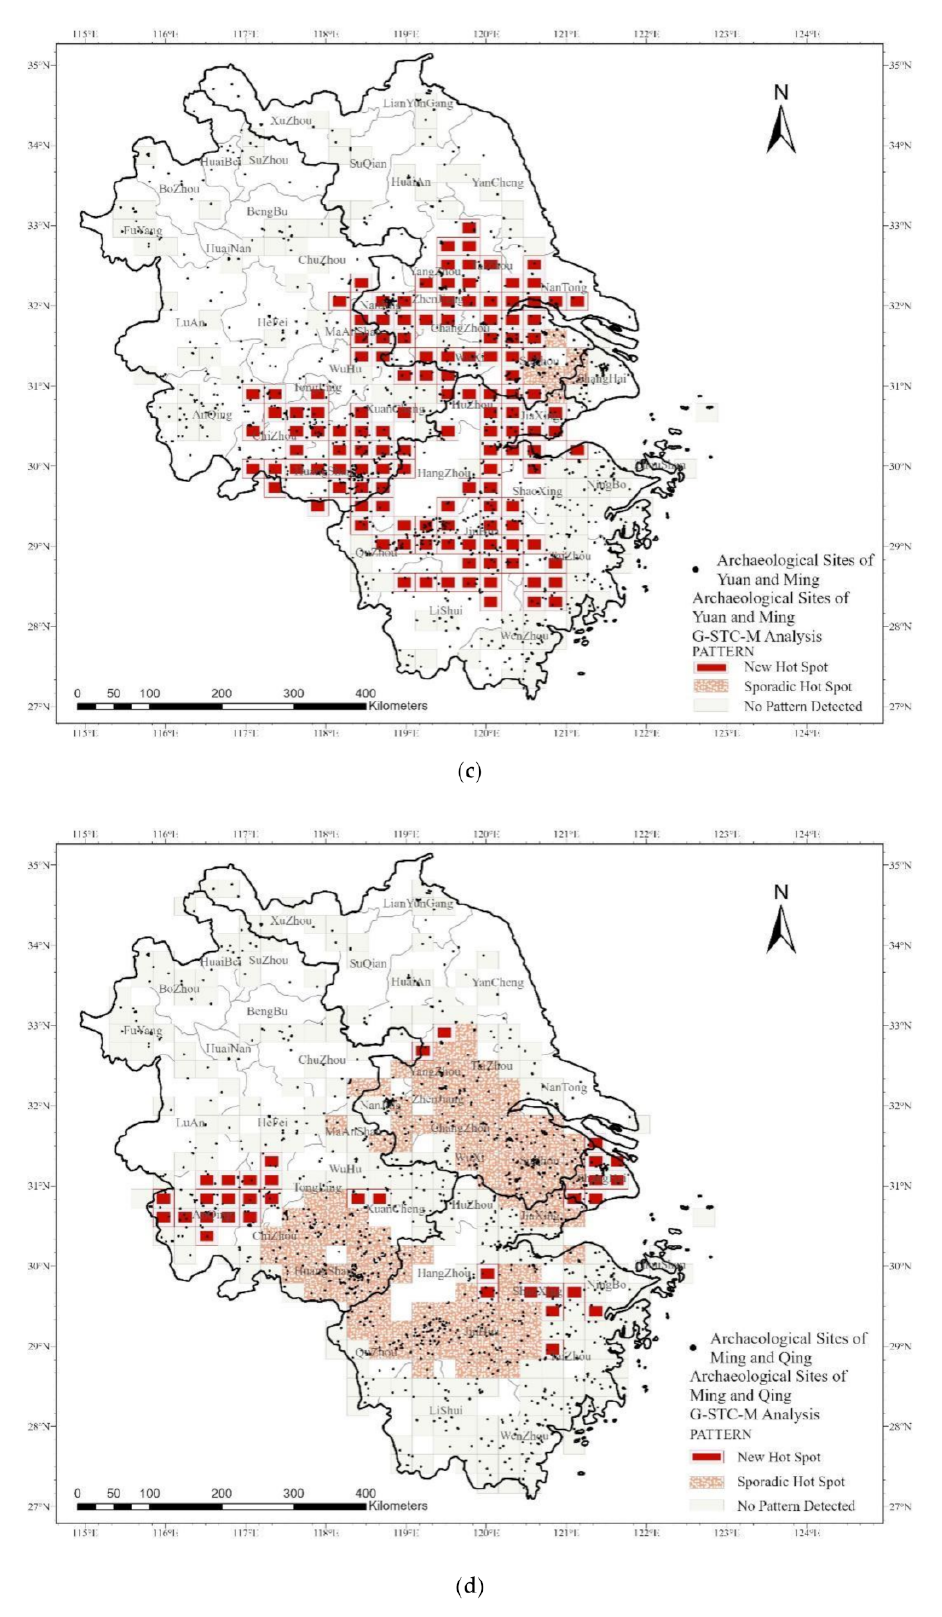
Figure 12. Analysis of space-time cube slices in Archaeological Sites. ( a ) G-STC-M analysis of Archaeological Sites of Tang and Song Dynasties, ( b ) G-STC-M analysis of Archaeological Sites of Song and Yuan Dynasties, ( c ) G-STC-M analysis of Archaeological Sites of Yuan and Ming Dynasties, ( d ) G-STC-M analysis of Archaeological Sites of Ming and Qing